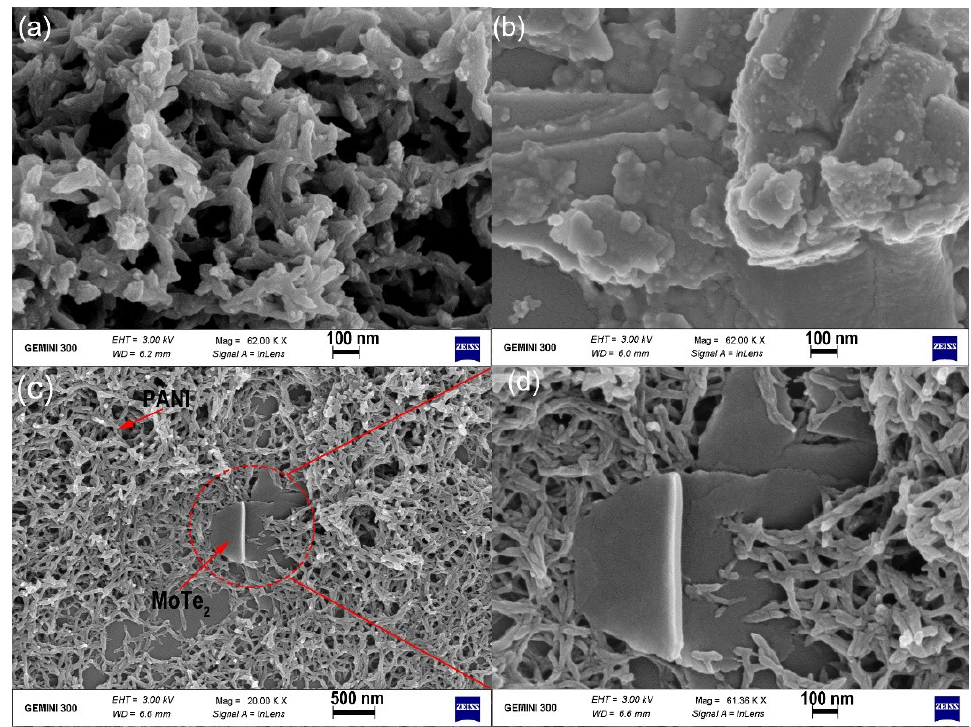
Figure 2. SEM images of ( a ) pure PANI, ( b ) MoTe 2 nanosheets, ( c ) MoTe 2 /PANI nanocomposites; ( d ) high-resolution SEM image of MoTe 2 /PANI nanocomposites (100 nm scale). HRTEM images of pure PANI, MoTe 2 nanosheets and MoTe 2 /PANI composites are